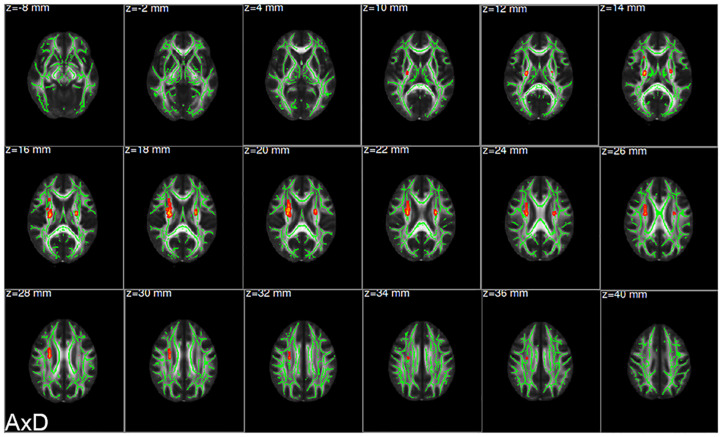
Clusters showing significant difference in axial diffusivity (AxD) values between the AD group and the HC group. The red clusters were attached to the axial images of the mean FA skeleton (green), showing significantly increased AxD values in the AD group compared with the HC group (AD > HC; FWE corrected P < 0.05). FWE, family wise error; AD, Alzheimer’s disease; HC, healthy controls.